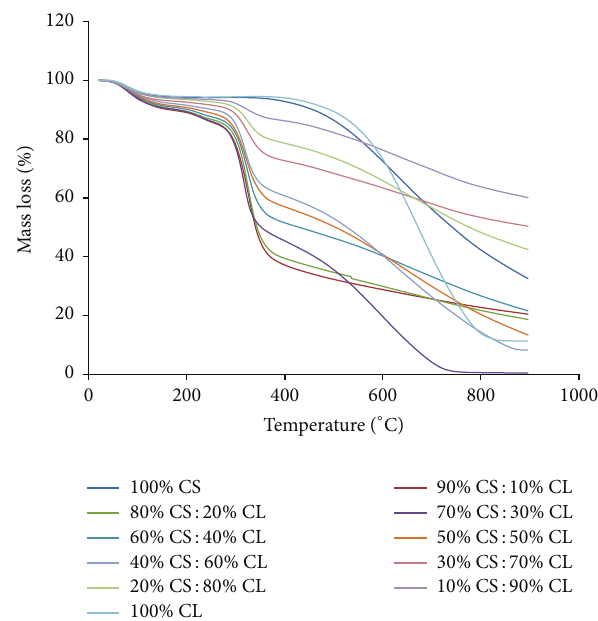
Figure 6: TGA of pure and blended samples of corn stover and